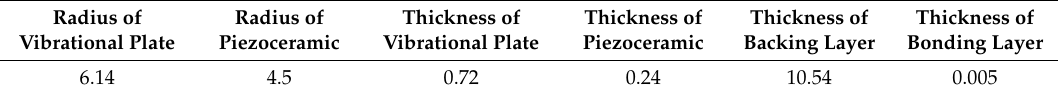
Table 2. Initial dimension of the multilayered structure (unit: mm) [25].